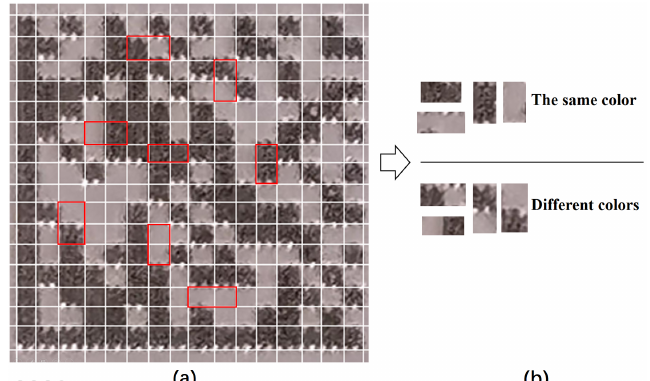
Figure 5. Proposal sampling: ( a ) sample by two adjacent modules; ( b ) samples and the classifica- tion labels.